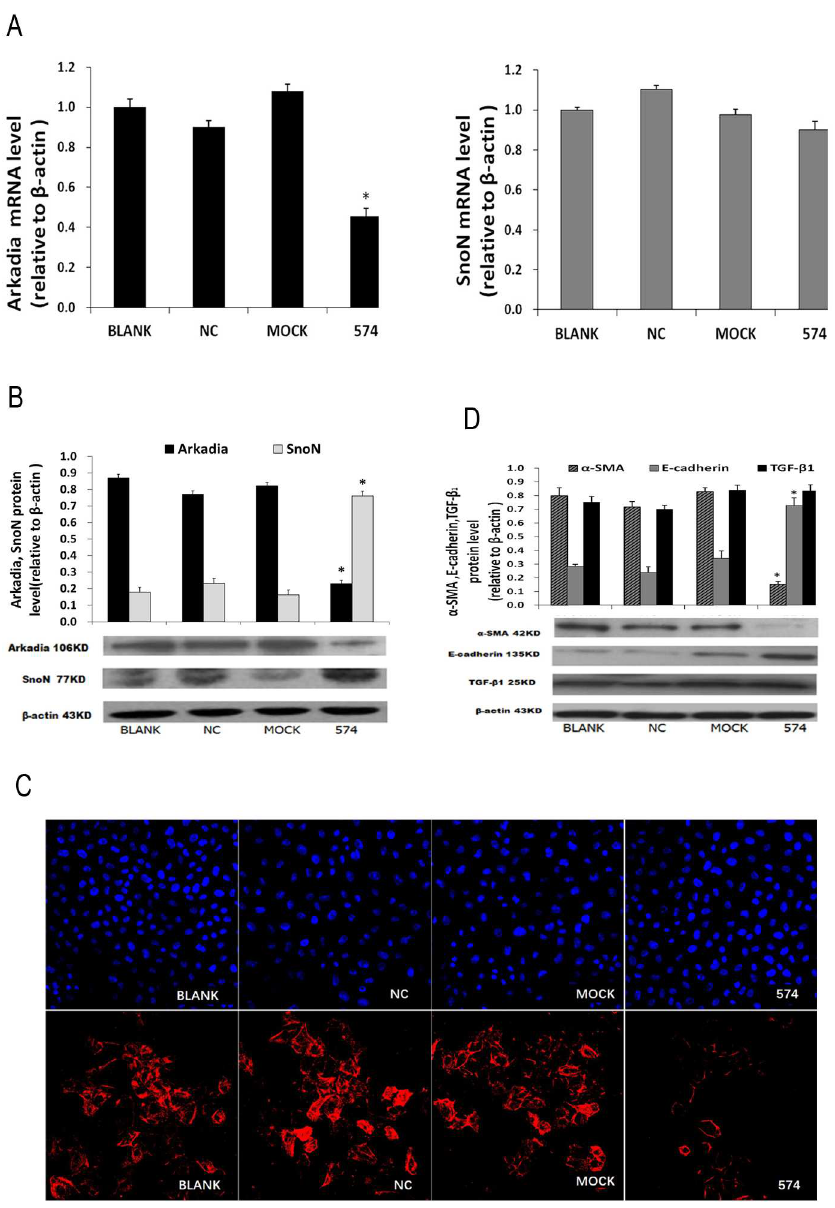
Fig 5. Upregulating SnoN by Arkadia silencing inhibits EMT in renal tubular cells under high glucose stress.A, Arkadia and SnoN mRNA levels determinedby qRT-PCR. B, Arkadia and SnoN protein amounts determined by Western blot. C, The expressionlevels of α -SMA in HK-2 cells assessedby fluorescence microscopy (200 × )(red, α -SMA; blue, nucleus). D, E-cadherin, α -SMA and TGF- β 1 protein levels determined by Western blot. * P < 0.05,vs.